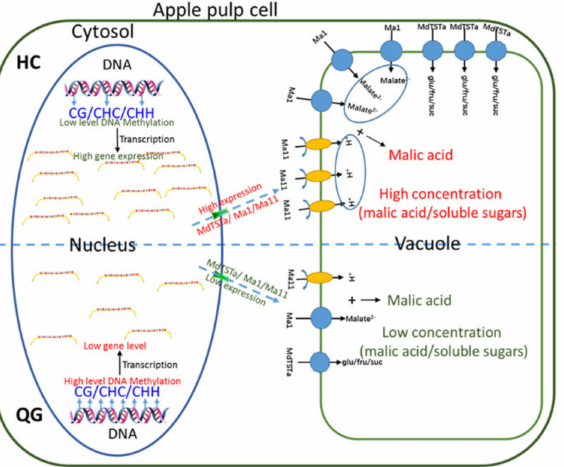
Figure 7. Proposed model for the epigenetic regulation of organic acid and soluble sugar in ‘HC’ and ‘QG’ mature fruits. Methylation levels are higher in ‘QG’ mature fruits than in ‘HC’ mature fruits. Additionally, MdTSTa mediates the transport of soluble sugars from the cytosol into the vacuole, whicle MdMa1 and MdMa11 transport malic acid and protons into the vacuole, respectively. Upregulated MdTSTa, MdMa1, and MdMa11 expression levels tend to result in higher vacuolar soluble sugar and malic acid concentrations in ‘HC’ mature fruits than in ‘QG’ mature